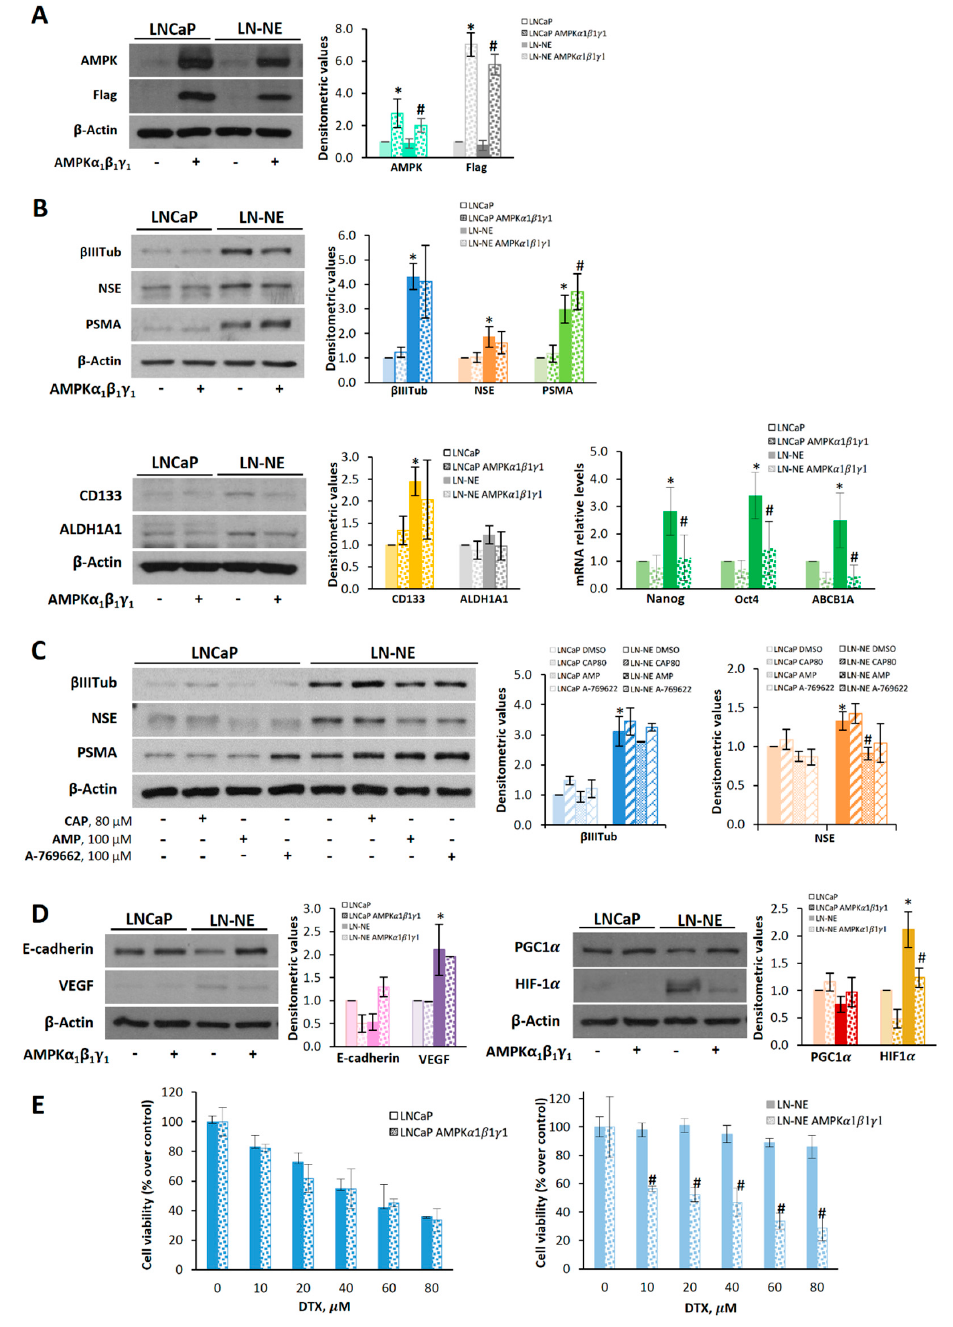
Figure 6. AMPK overexpression or AMPK activation decreases neuroendocrine and stem markers in LN-NE cells and restores sensitivity to docetaxel. ( A ) AMPK α 1 β 1 γ 1 was overexpressed in LN-NE cells by transfection with Flag-tagged plasmids containing the three AMPK subunits. ( B ) Effect of the overexpression of AMPK α 1 β 1 γ 1 on neuroendocrine markers and on CD133 and ALDH1A1